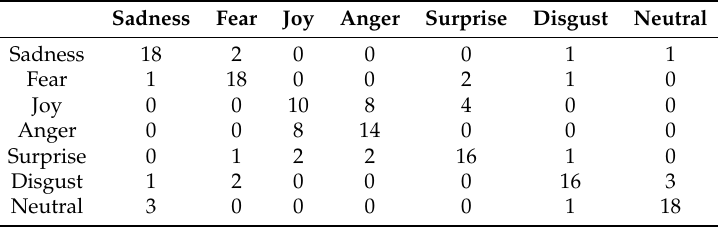
Table A3. P3 actor confusion matrix from the RekEmozio dataset in the second phase.